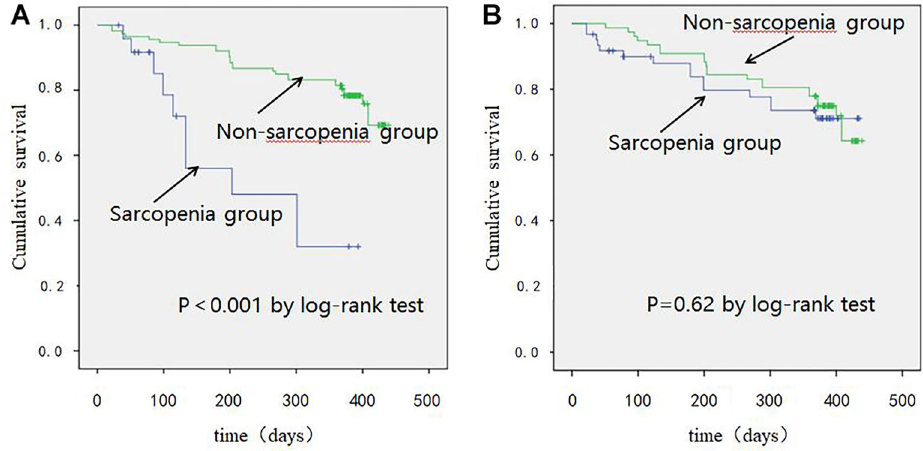
Figure 2. Kaplan-Meier analysis for rehospitalization. A : Dichotomy by the SARC-F score, log-rank test w 2 =18.39, P o 0.001. B : Dichotomy by Ishii ’ s score, log-rank test w 2 =0.24, P=0.62.